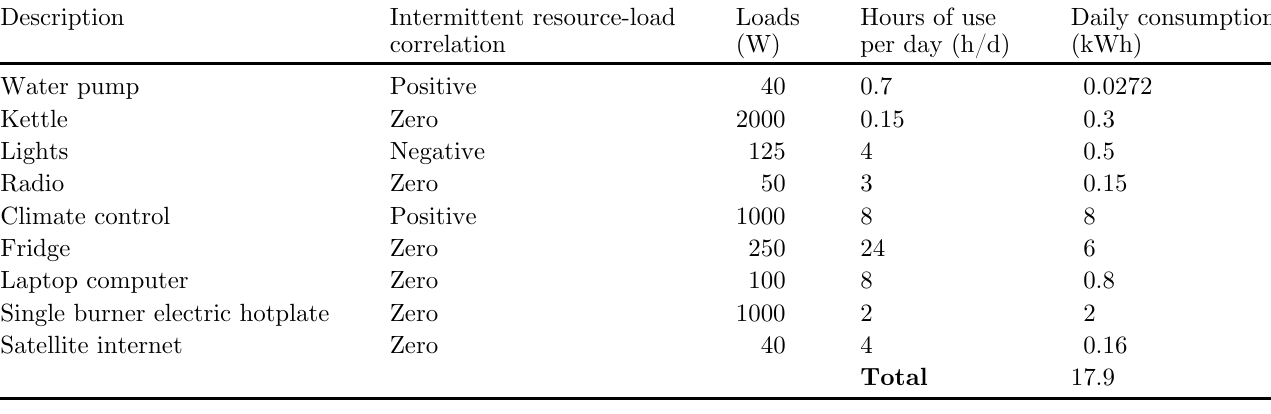
Table 2. Load estimation for household appliances.